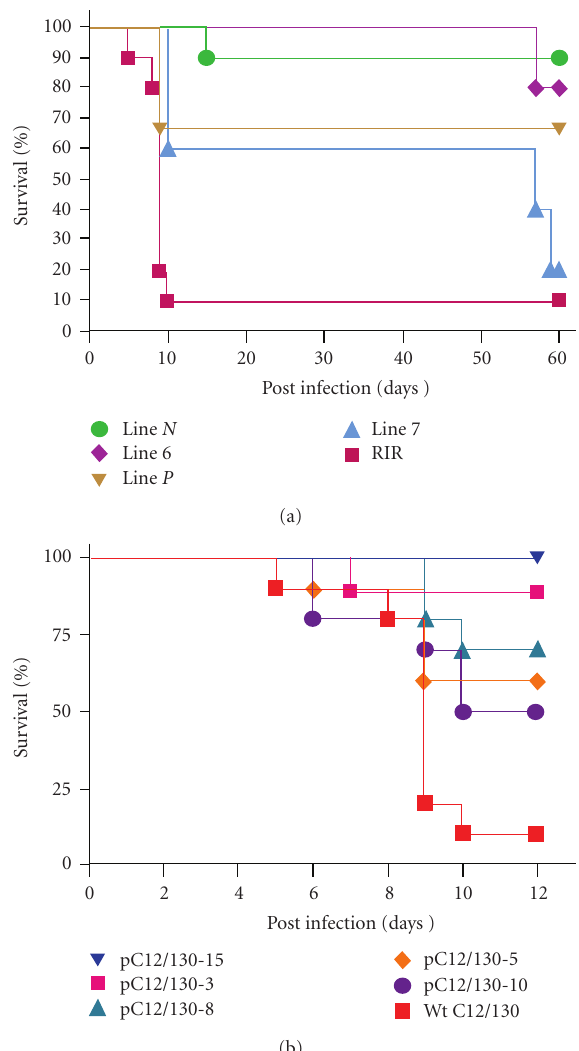
Figure 2: Survival curves of birds infected with C12/130 viruses. Cumulative percentage of survival of (a) genetically distinct lines of birds challenged with wild-type C12/130 virus during the 60-day experimental period ( n = 10), and (b) RIR chicks infected with wild-type C12/130 virus and the reconstituted viruses from pC12/130-3, pC12/130-5, pC12/130-8, pC12/130-10, and pC12/130-15 during the 12-day experimental period ( n =